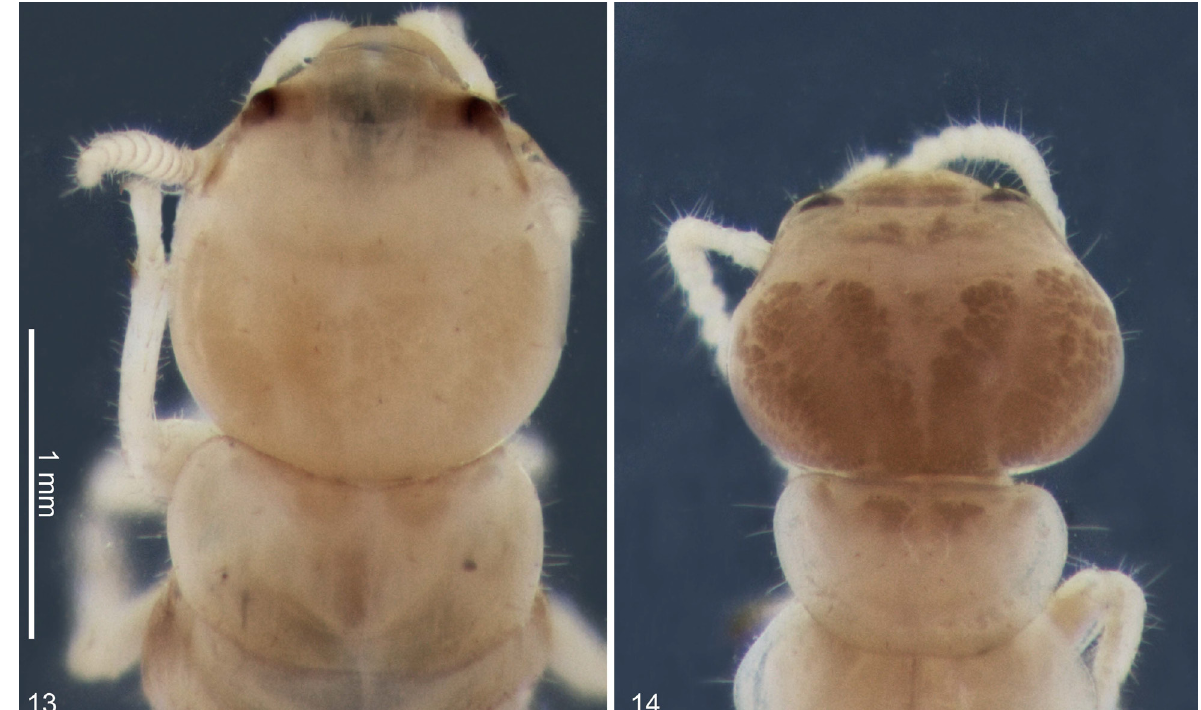
Figs 13–14. Pseudergates in dorsal view: 13- Prorhinotermes simplex ; 14- Rugitermes